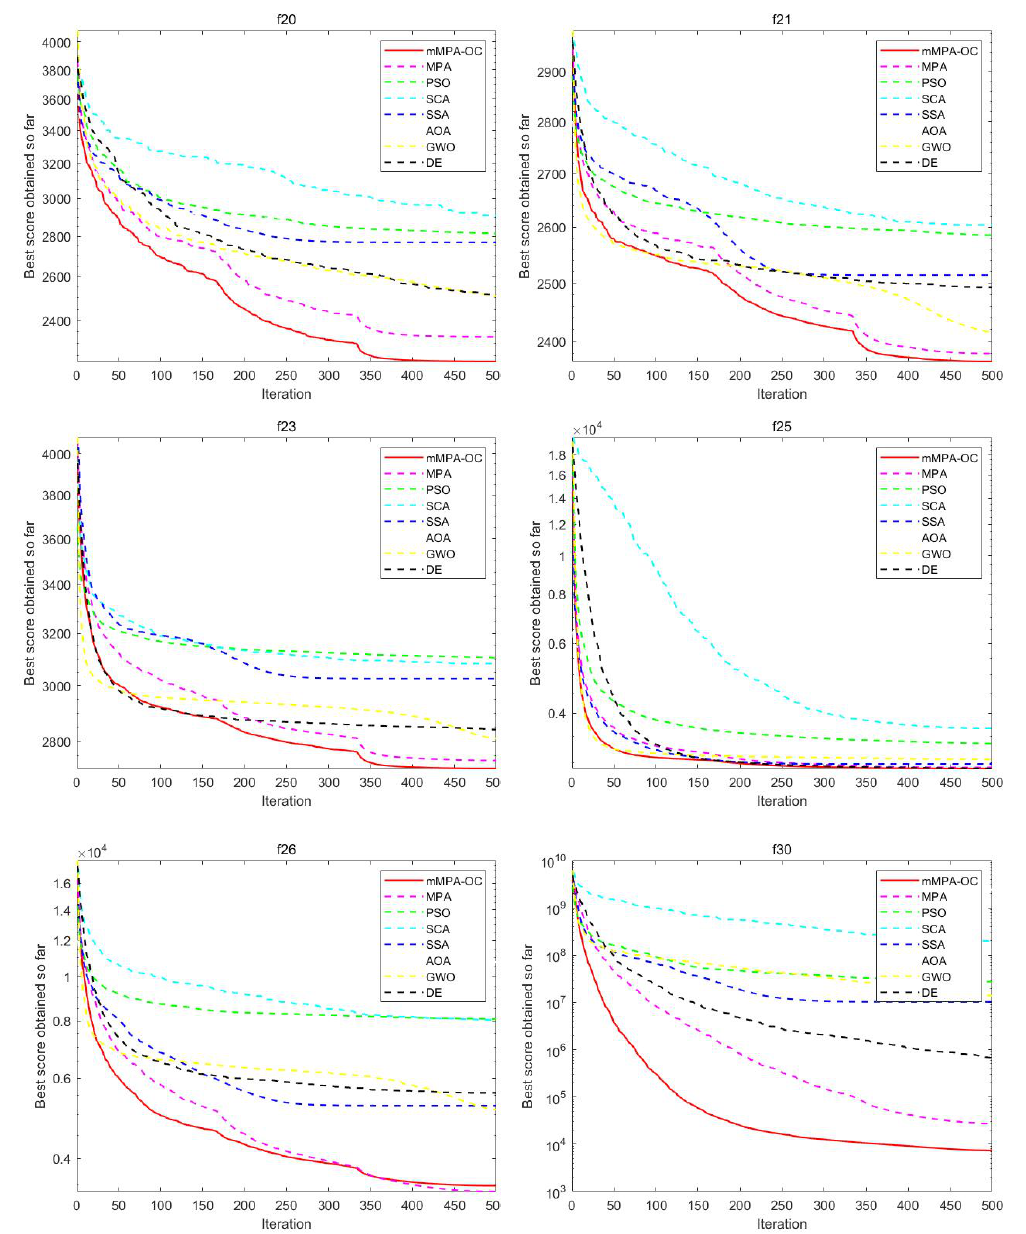
Figure 4. Convergence curve of CEC-2017 test function (30